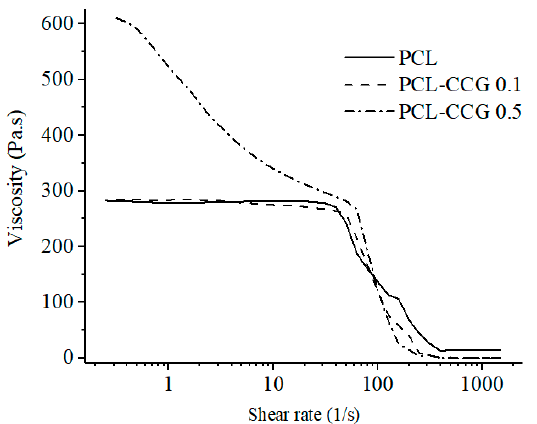
Figure 2. The apparent viscosity value of the PCL and PCL composites as a function of shear rate.